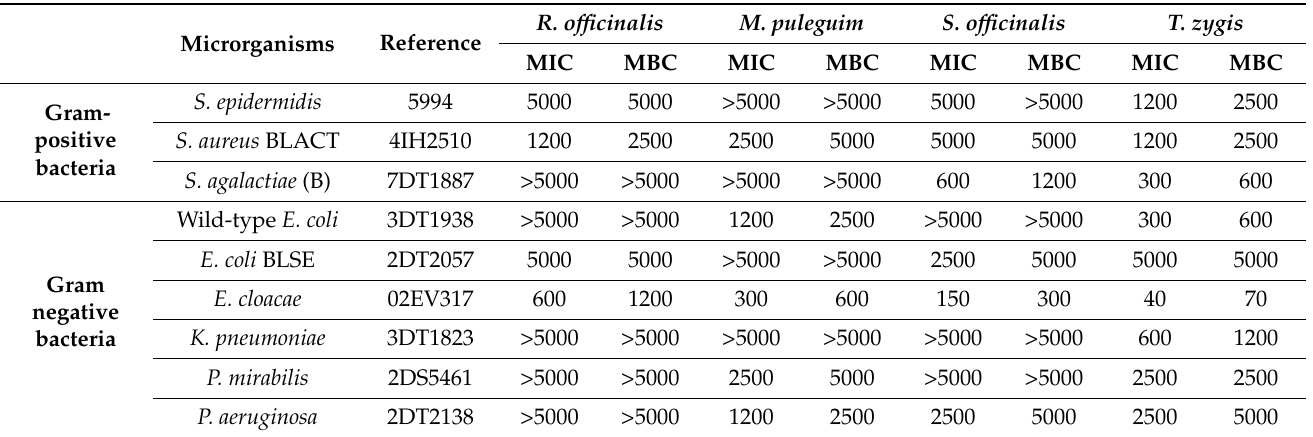
Table 3. Minimum Inhibitory Concentration (MIC) and Minimum Bactericidal Concentration (MBC) of the studied species’ EOs ( µ